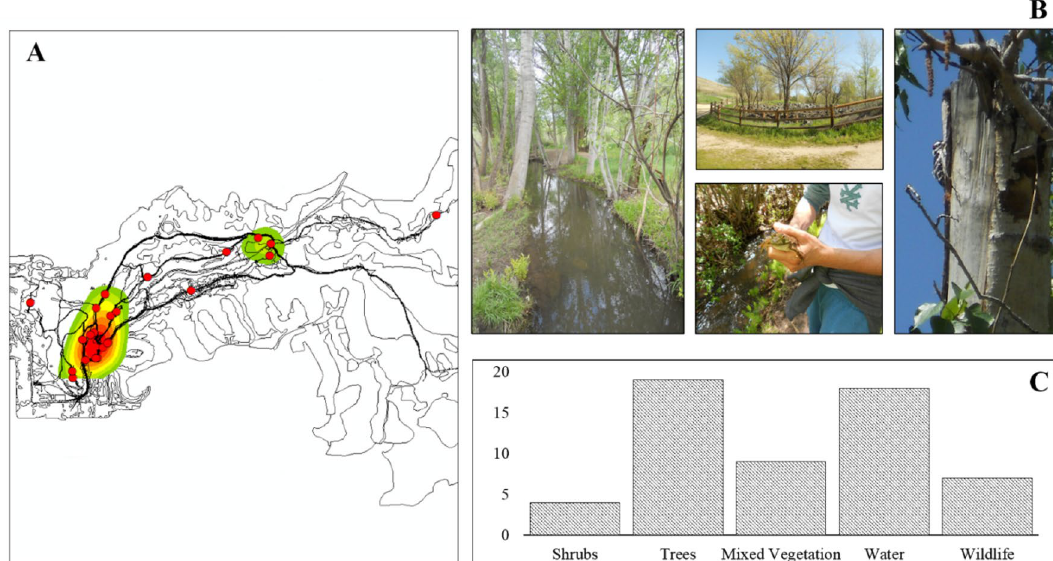
Figure 4. Volunteer employed photography results including ( A ) kernel density estimate (KDE) of photo points, ( B ) a sample of representative photographs from the area of highest photographic density, and ( C ) a bar graph depicting the various photographic elements captured by each participant (n = 22). KDE estimates are shown alongside land cover type boundaries, participant tracks (black), and photo points (red). Densities are depicted from highest to lowest where red refers to high photographic density, and green as low photographic